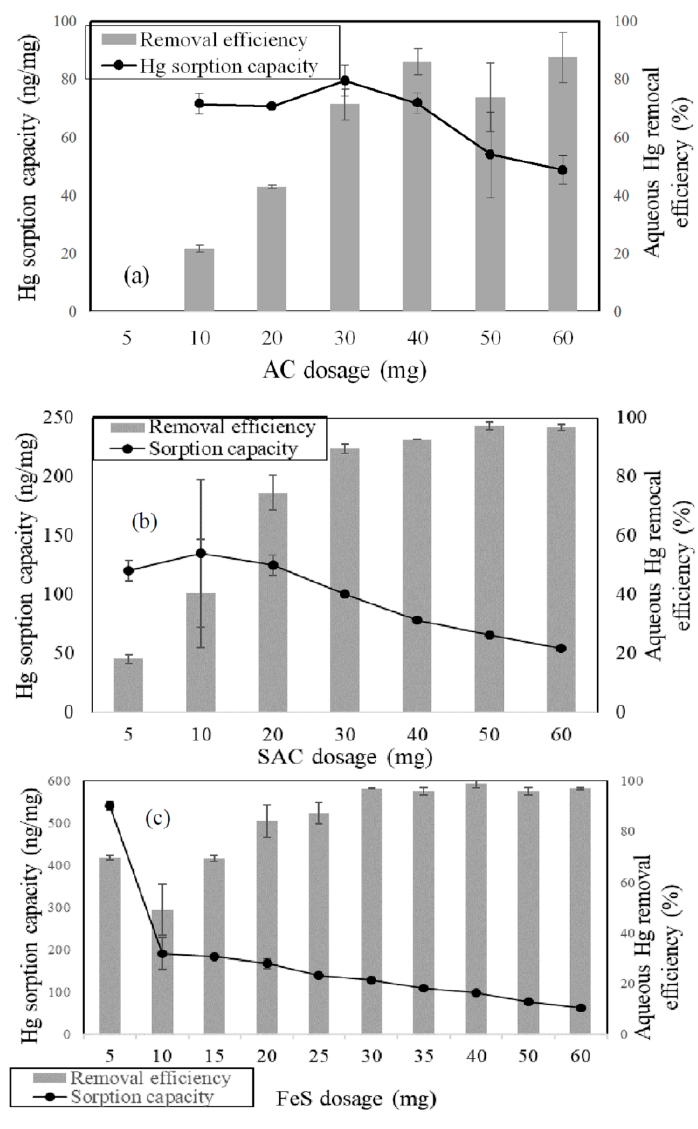
Figure 2. E ff ect of ( a ) AC; ( b ) SAC; ( c ) FeS dosage on Hg removal e ffi Figure 2. Effect of ( a ) AC; ( b ) SAC; ( c ) FeS dosage on Hg removal efficiency.